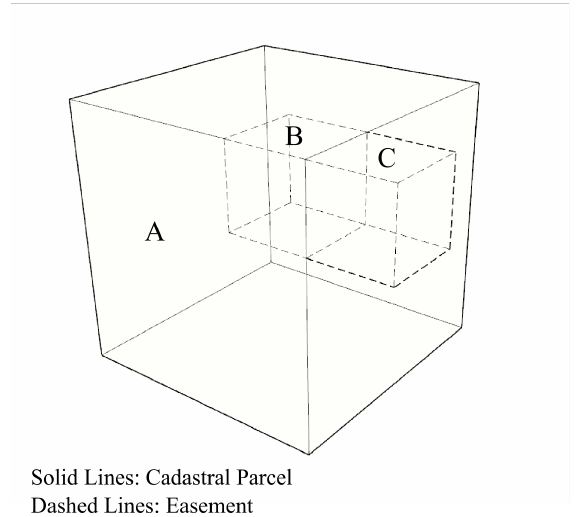
Figure 3. 3D geometry depicting two overlapping geometries A simplified approach might model the cadastral parcel and the easement independently of each other. There is no expli- cit definition of the relationship between the two spatial units in this instance. If such an approach is adopted, from a cadas- tral surveying perspective, it is recommended that an intersec- tion curve, similar to CityGML’s terrain intersection curve, be defined to describe explicitly where the two solids